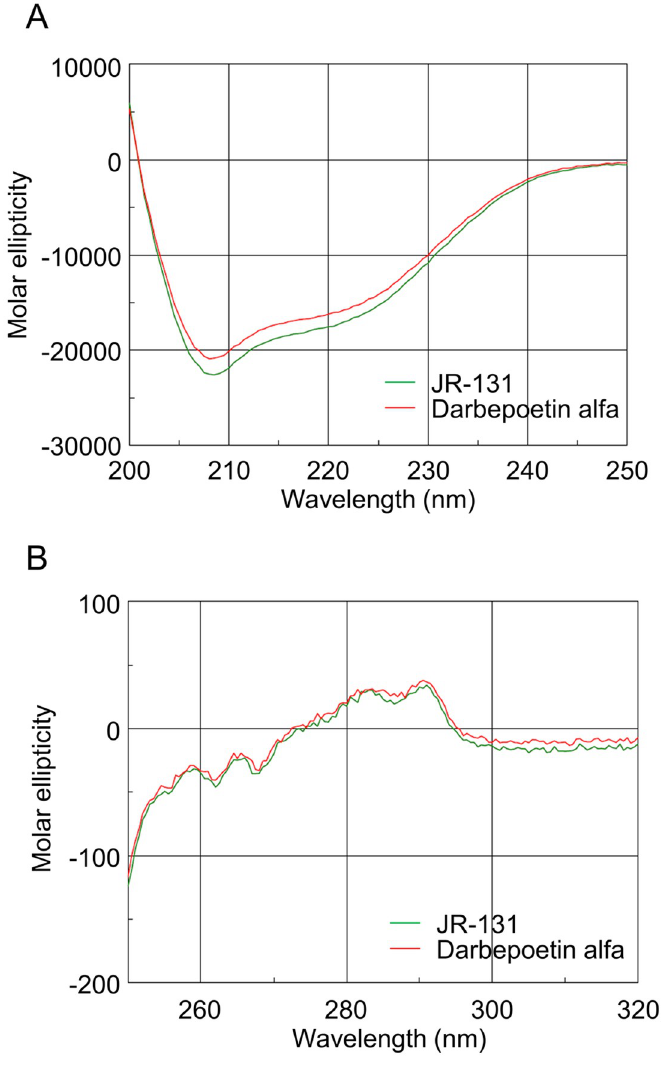
Fig 2. CD spectra of JR-131 and darbepoetin alfa. (A) Far-UV and (B) near-UV spectra are presented.